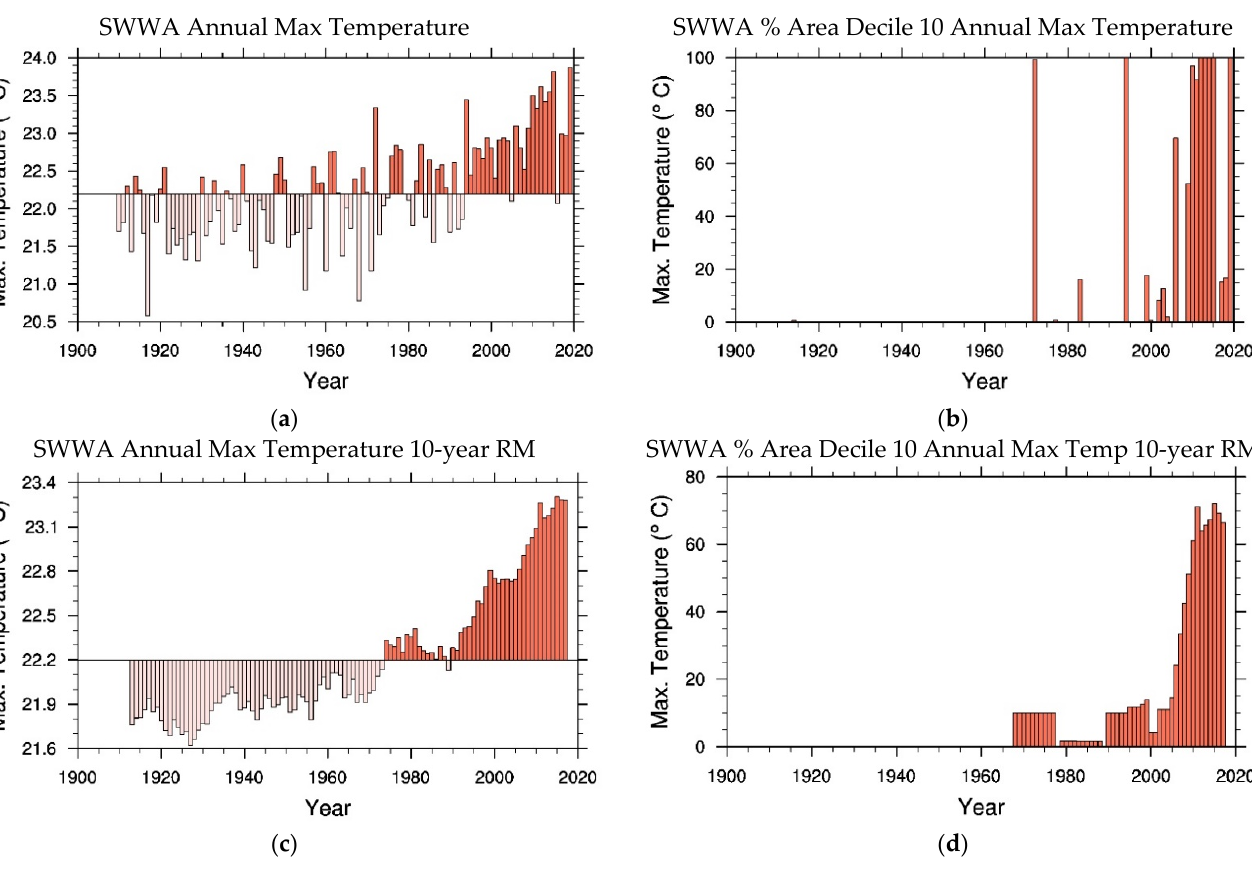
Figure 8. ( a ) SWWA annual maximum temperature variability (°C), ( b ) SWWA percentage area (%) with maximum annual temperatures in decile 10 (PAT D10 ), ( c ) 10-year RM of SWWA annual maximum temperatures and ( d ) 10-year RM of SWWA PAT D10 . Table 9. The annual mean of maximum temperatures and percentage areas with maximum tempera- tures in decile 10 (PAT D10 ) for SWWA, SEA, NSW, MDB and TAS and Australian PAT D10 for mean and maximum temperatures, for different time